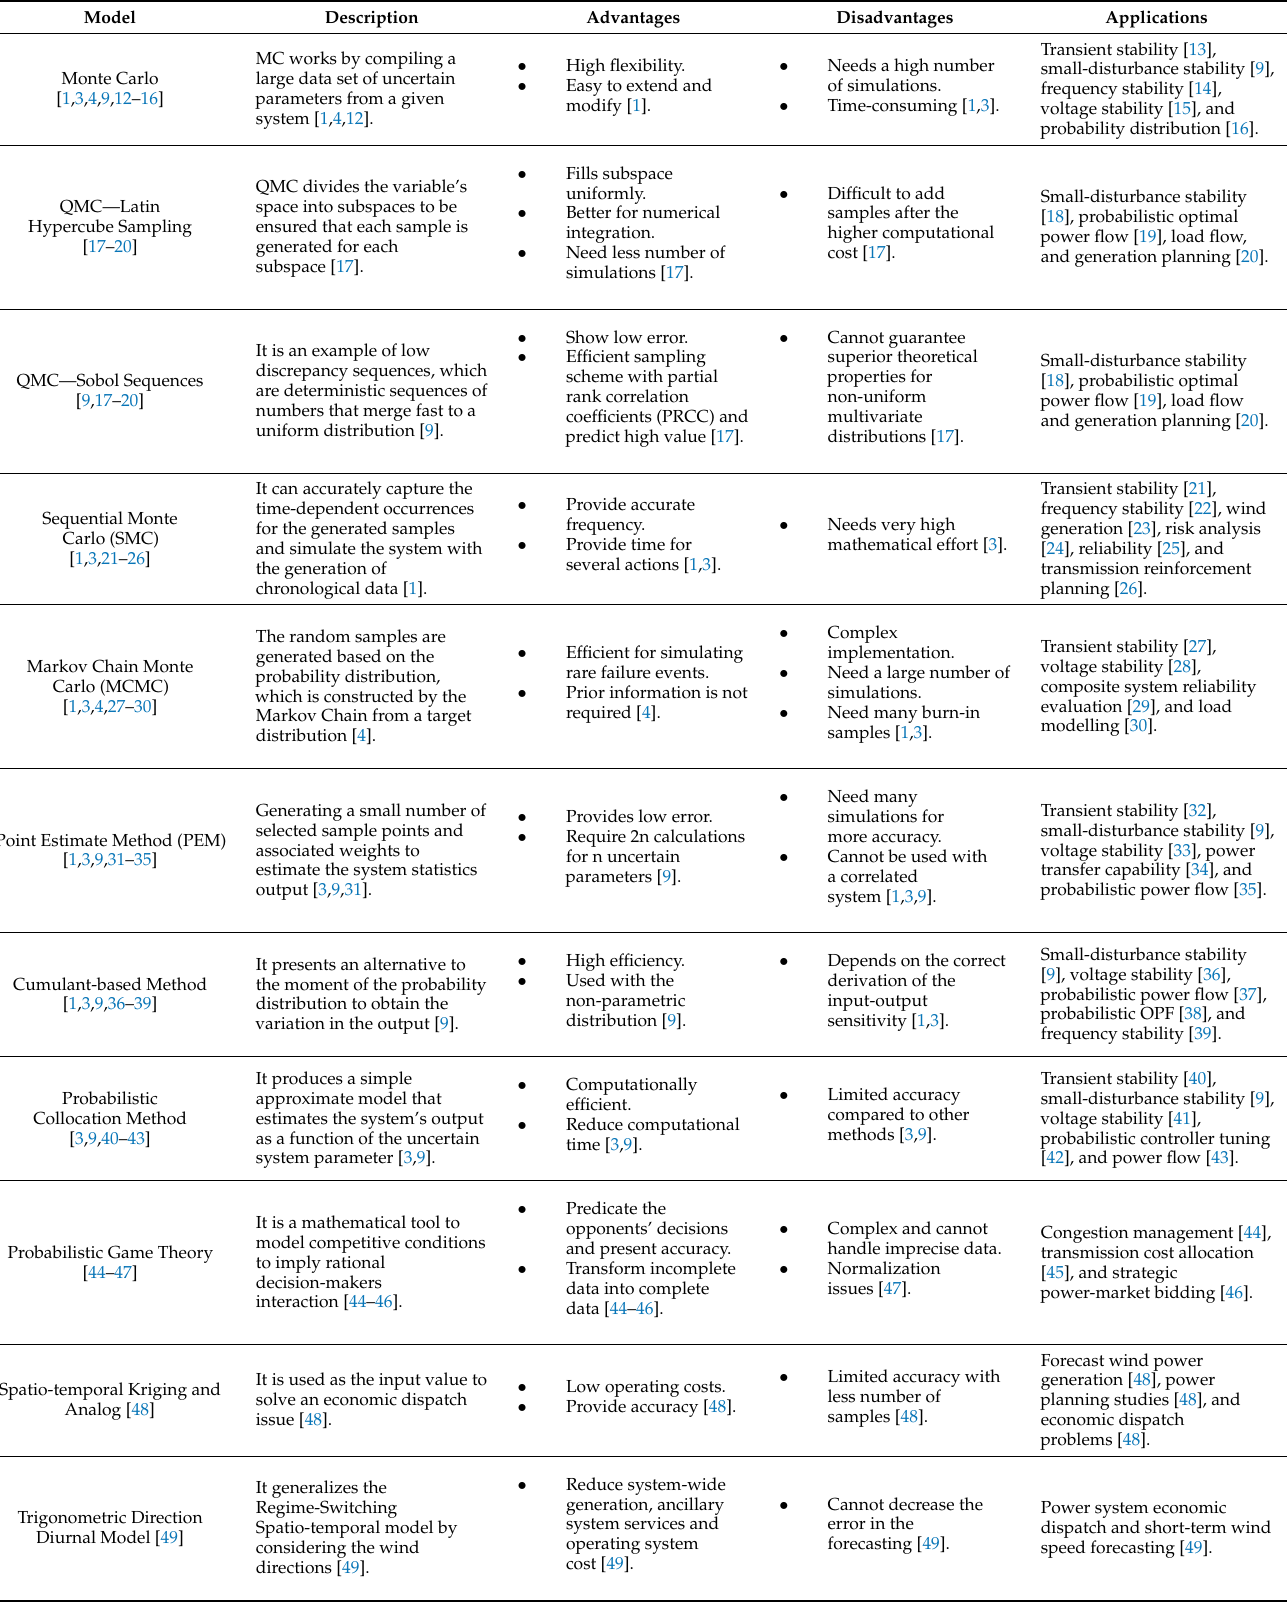
Table 1. Uncertainty modelling techniques with their description, advantages, disadvantages, and